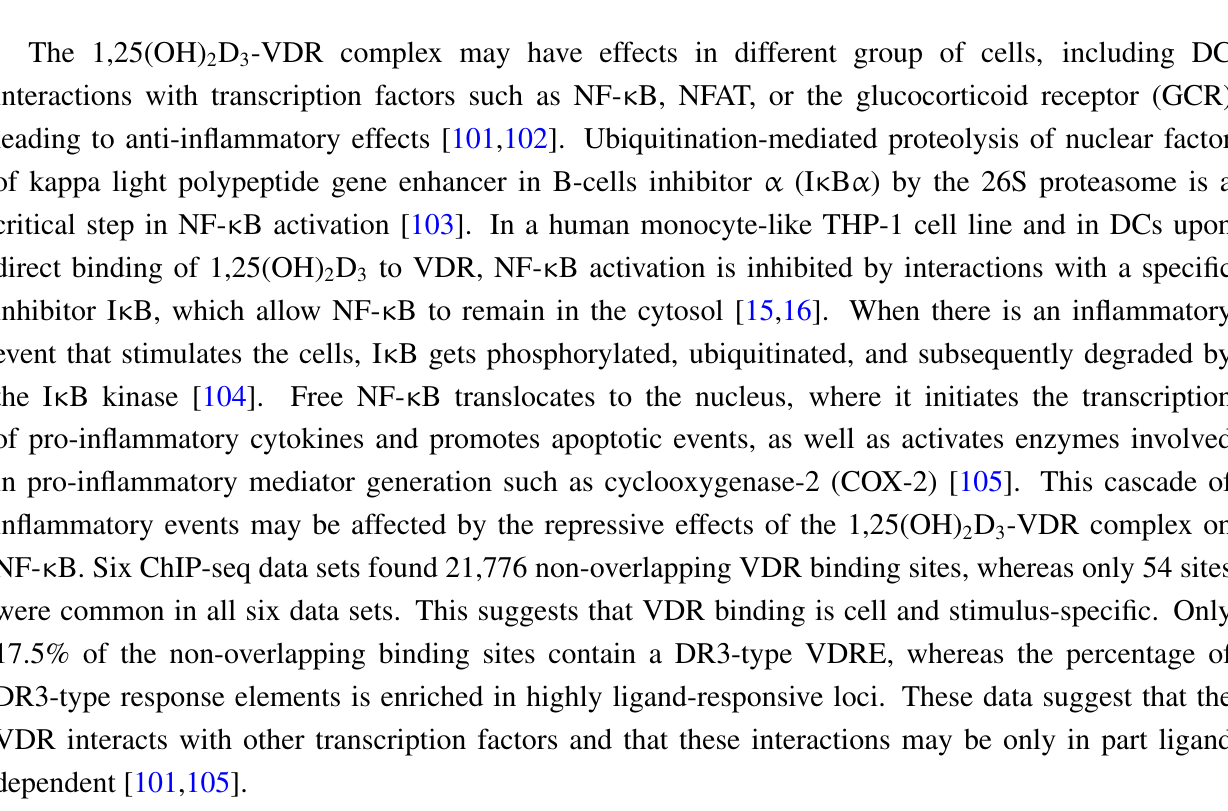
Figure 2. The influence of 1,25(OH) 2 D 3 on the expression of interleukins, cytokines and regulatory molecules in different DC subsets.